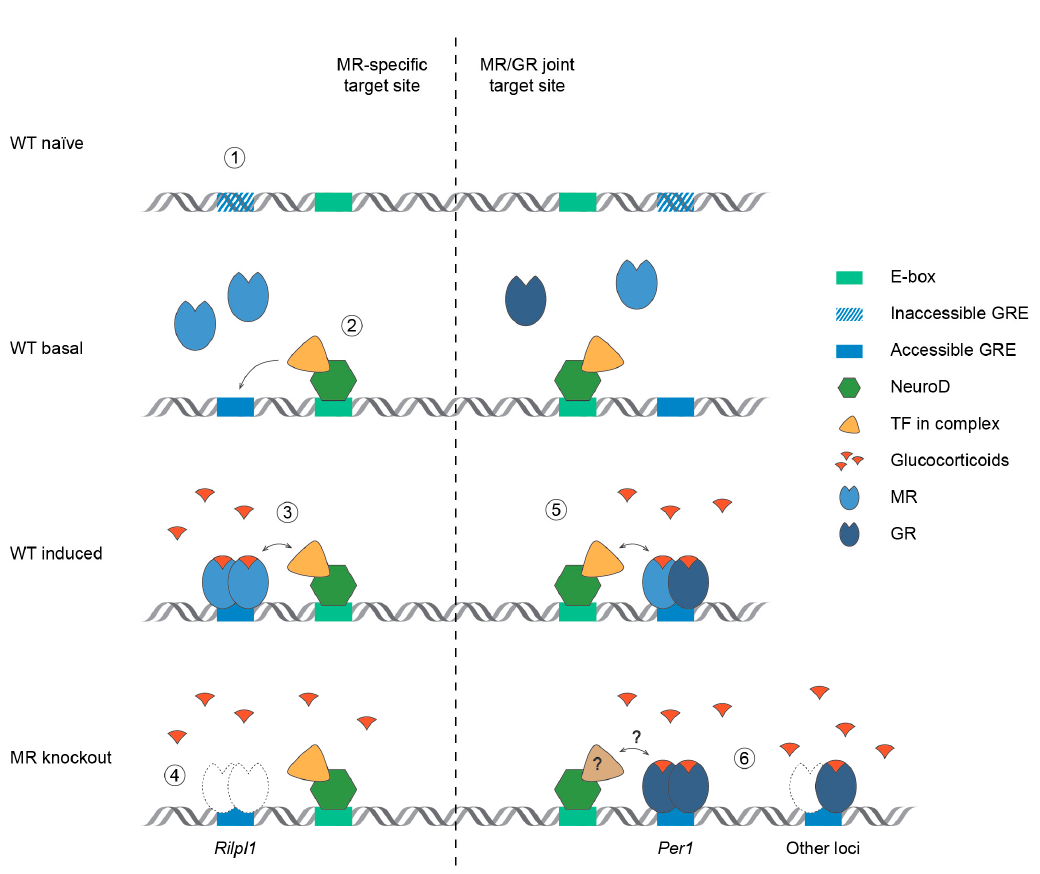
Figure 4. Summary of the interaction between hippocampal MR and NeuroD. Glucocorticoid response elements (GREs) previously inaccessible ( 1 ) could be rendered accessible by chromatin remodeling (one-way arrow) induced by NeuroD ( 2 ) binding at a nearby E-box (the NeuroD-specific sequence CAGATG). Upon ligand availability MR can bind an accessible GRE ( 3 ) in order to modulate transcriptional activity of its target genes. This interaction between NeuroD and MR (two-way arrow) is likely mediated via additional TF(s) in the transcriptional complex [9]. In forebrain MR knockout mice ( 4 ) GR is not compensating for the lack of MR binding at the MR-specific Rilpl1 site. Also at several MR/GR joint target sites ( 5 ) NeuroD occupancy is observed in the vicinity. Of note, we cannot discriminate between the binding of homo- and heterodimers in the present study. In absence of MR ( 6 ) GR binding is increased at the Per1 promoter, while for the other tested loci GR binding levels are unaltered. For sites that become GR-specific due to MR knockout, interactions with NeuroD remain to be explored, and other TF(s) might be involved ( ? ). MR = mineralocorticoid receptor, GR = glucocorticoid receptor, GRE = glucocorticoid response element, TF = transcription factor, WT = wild